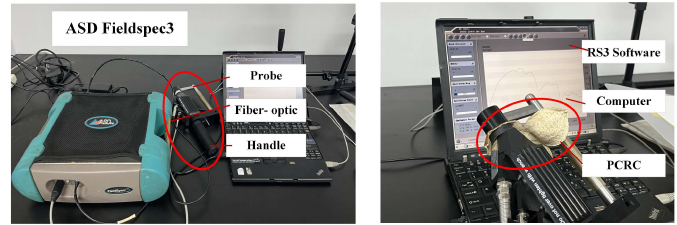
Figure 5. Physical image of the multi-spectrum test